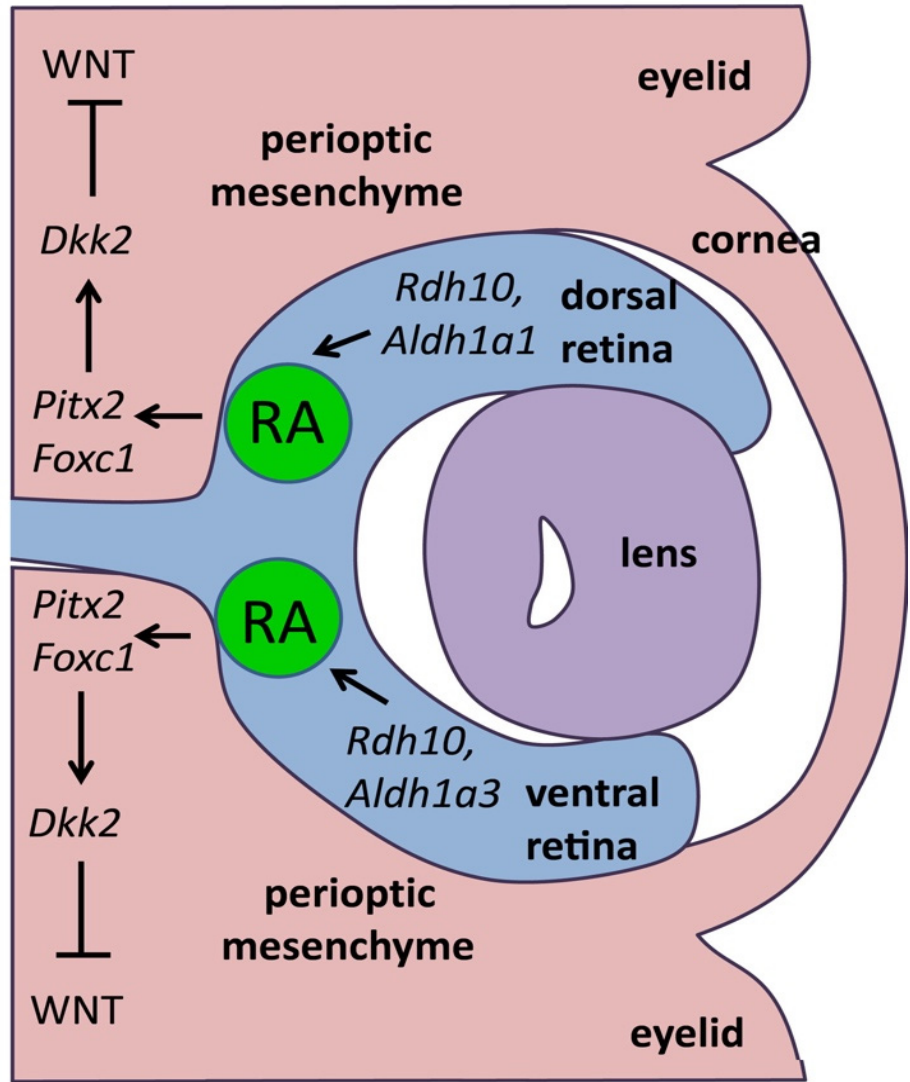
Figure 3. RA is generated in dorsal/ventral retina and diffuses to perioptic mesenchyme where it is required during anterior eye formation (cornea/eyelid) to activate Pitx2 which then activates Dkk2 that functions to repress WNT signaling to limit perioptic mesenchyme growth; adapted from [31].